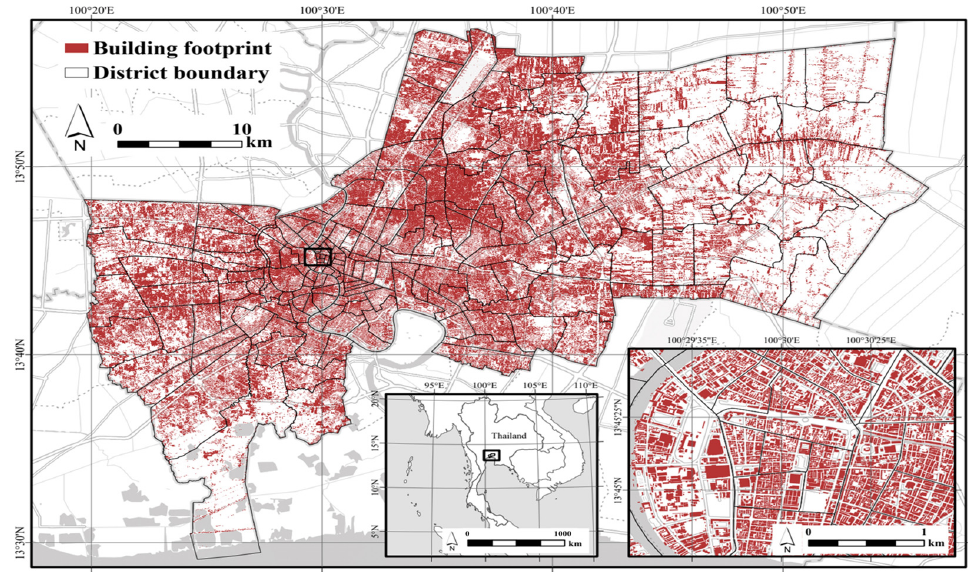
Figure 3. Building footprint data for Bangkok, Thailand.